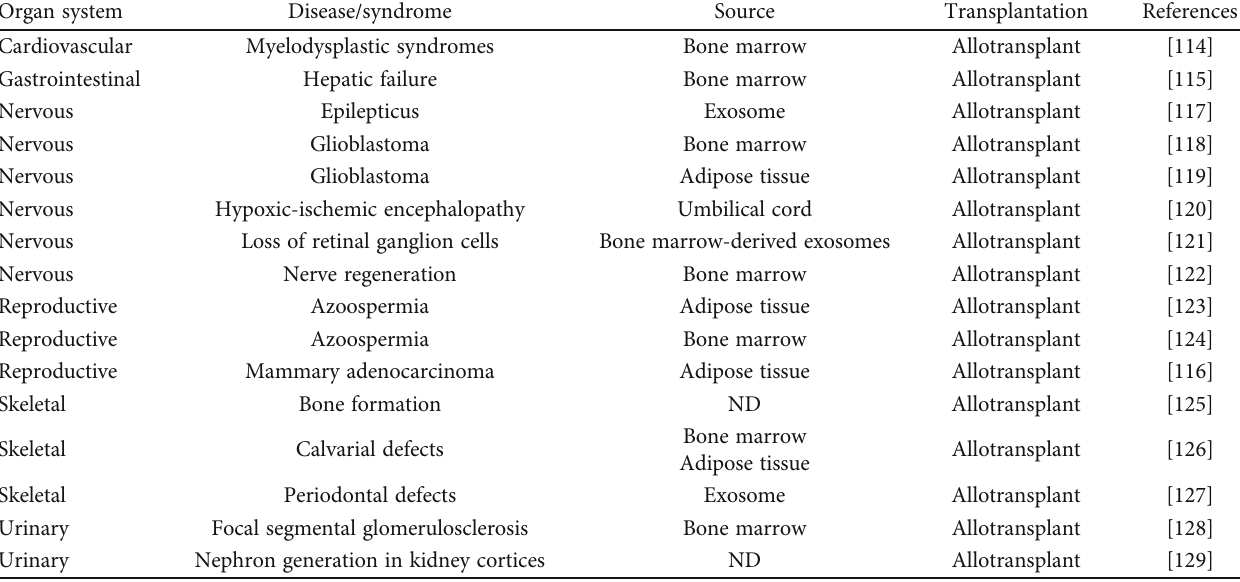
Table 4: Diseases can be tested clinically for treatment with mesenchymal stromal/stem cells in human based on the successful in vivo model studies.